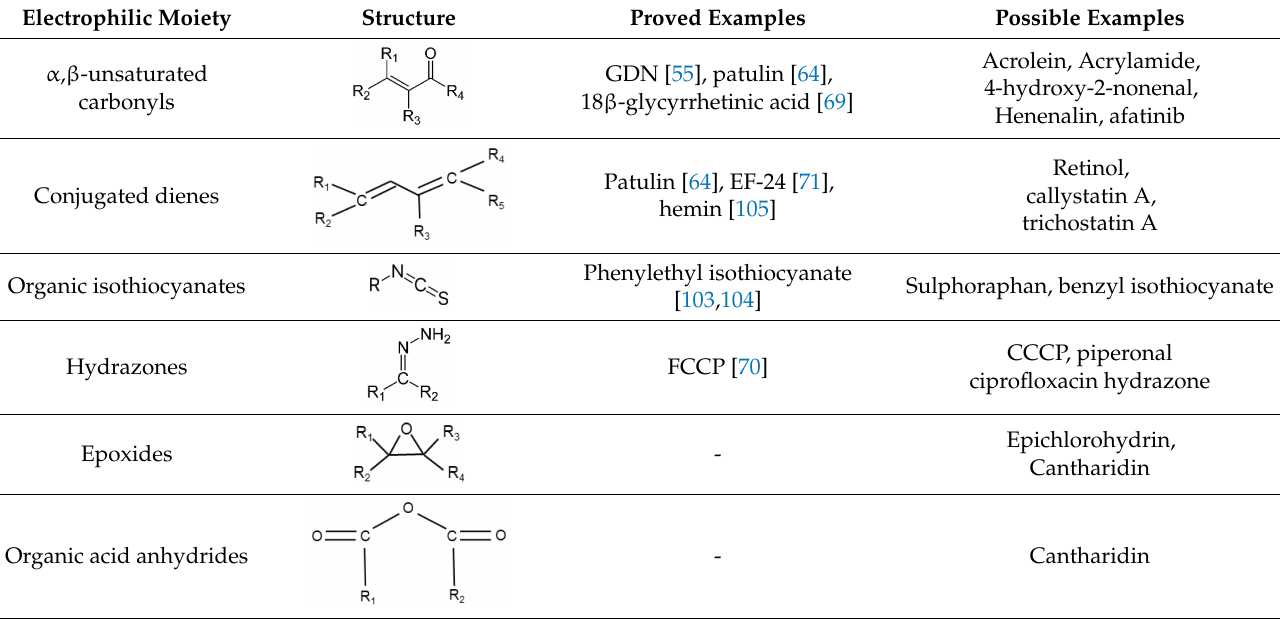
Table 2. Electrophiles which cytotoxicity are or could be prevented by nucleophilic interaction with